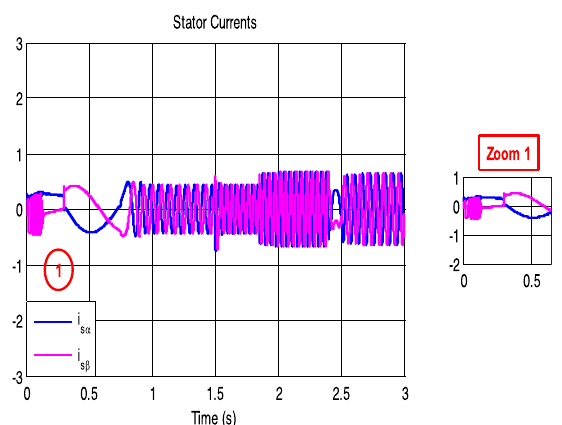
Fig. 18 PI-DTC-SPWM with five-level inverter stator current components